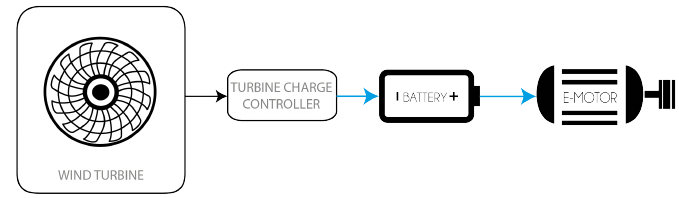
Figure 11. A diagram of the configuration of wind energy extended